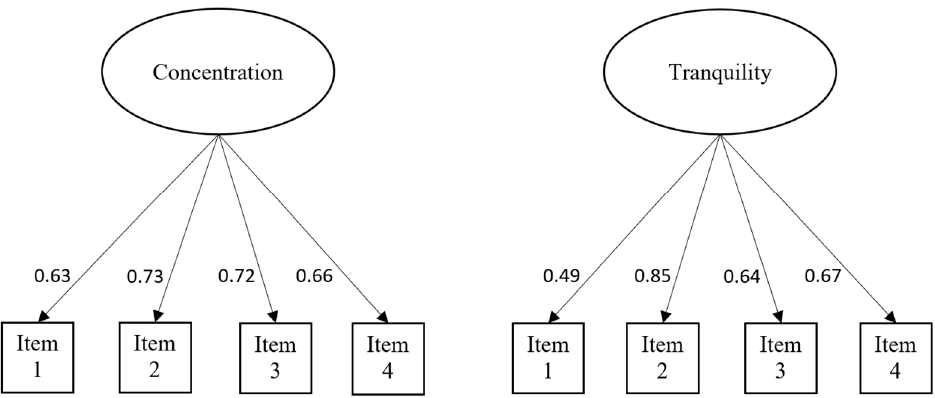
Figure 1. Results of confirmatory factor analysis of the Concentration Scale and Tranquility Scale.